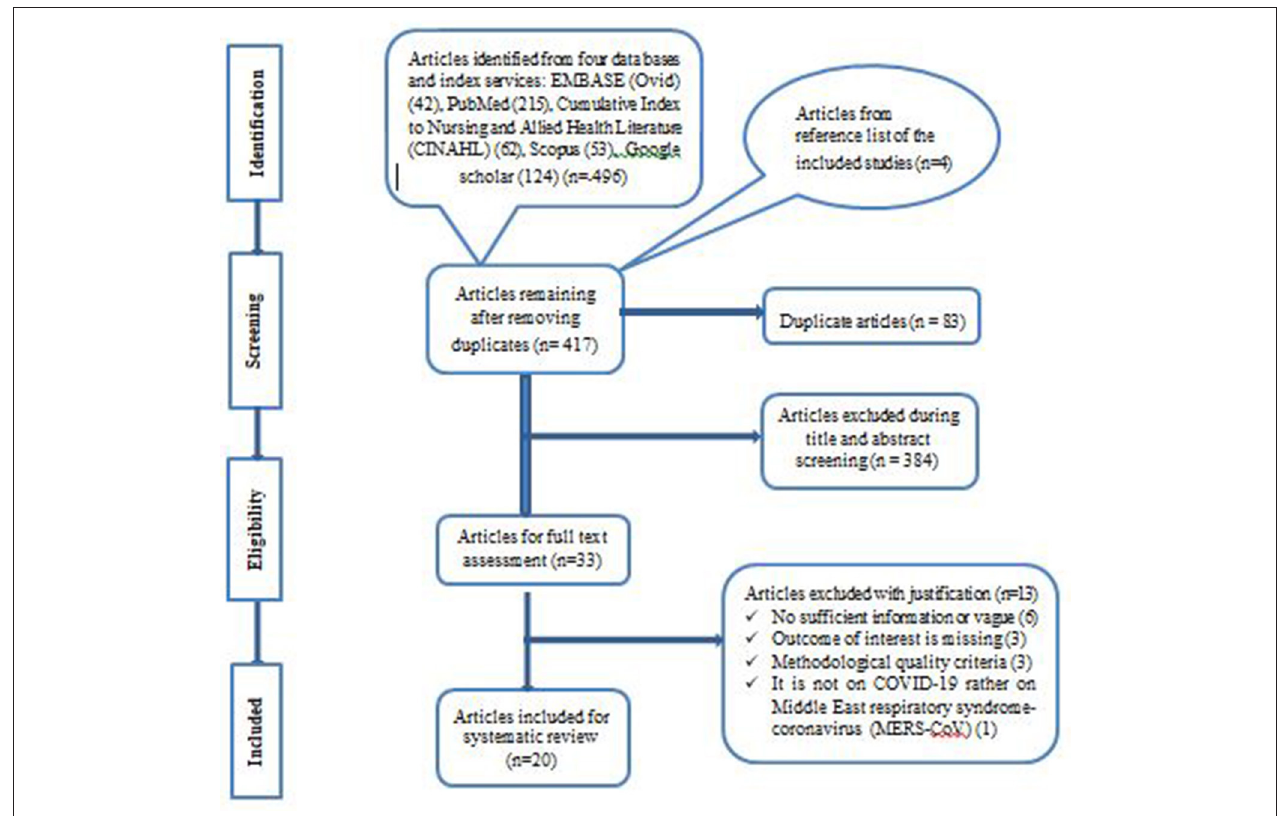
FIGURE 1 | PRISMA flow chart of the study selection